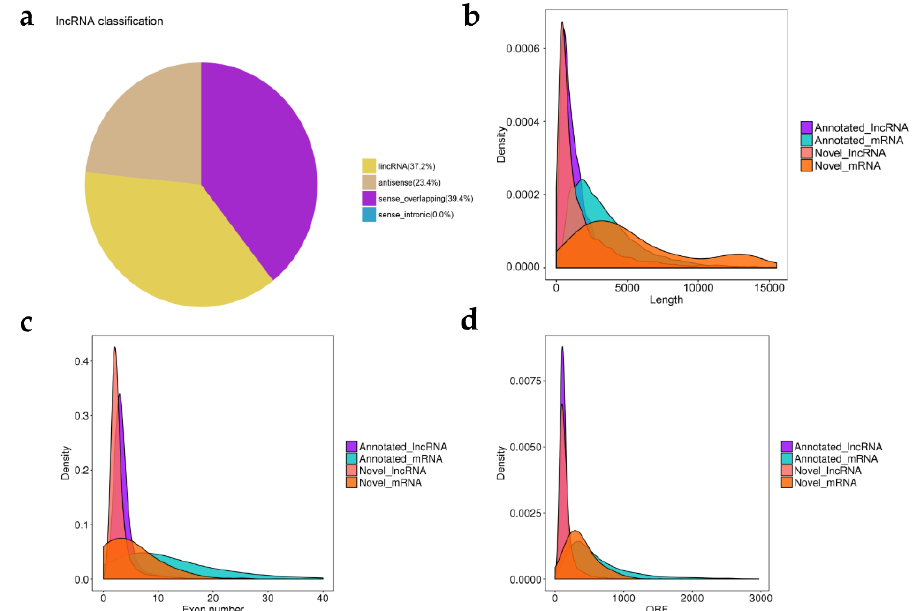
Figure 2. Characterization of lncRNAs. ( a ) Classification and characteristic analysis of lnRNAs. Distri-